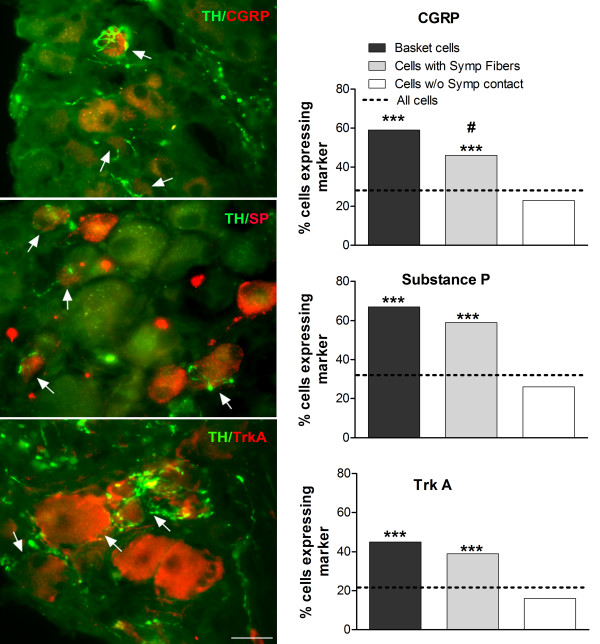
Distribution of nociceptive markers in cells with and without sympathetic contacts. DRG sections were stained for the indicated marker (red) and for TH (green) on POD3. Left: examples of dual staining from fixed DRG sections. Arrows indicate examples of cells expressing the indicated marker along with sympathetic basket formations or nearby fibers. (Scale bar = 25 μm). Right: summary of percentage of cells in each class expressing the indicated marker. ***, percentage of cells with basket/ring formations or with nearby sympathetic fibers expressing each marker was significantly higher (p < 0.001) than the percentage observed in cells lacking sympathetic contacts. #, significant difference (p < 0.05) between the basket cells and cells with nearby fibers (Chi-square test). The dotted lines indicating the overall percentage of cells expressing each marker on POD 3 are close to the values for cells with no sympathetic fibers because only 18 - 22% of cells have any sort of sympathetic contact. Data are combined from 3 separate animals for each marker; findings were similar within each individual group. N values for each group are given in Table 1.